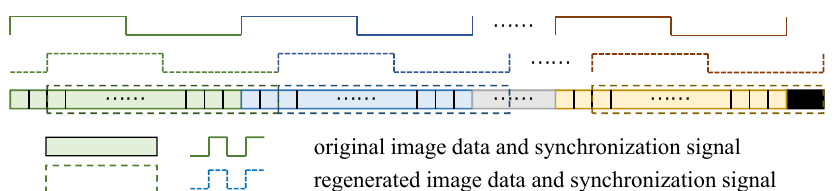
Figure 4. Original image data, synchronization signal and the regenerated ones.